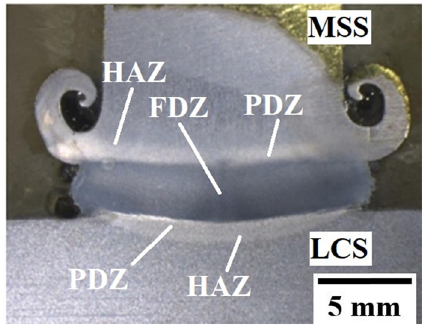
Figure 8: Cross - sectional macrostructure of rod - to - plate joint.